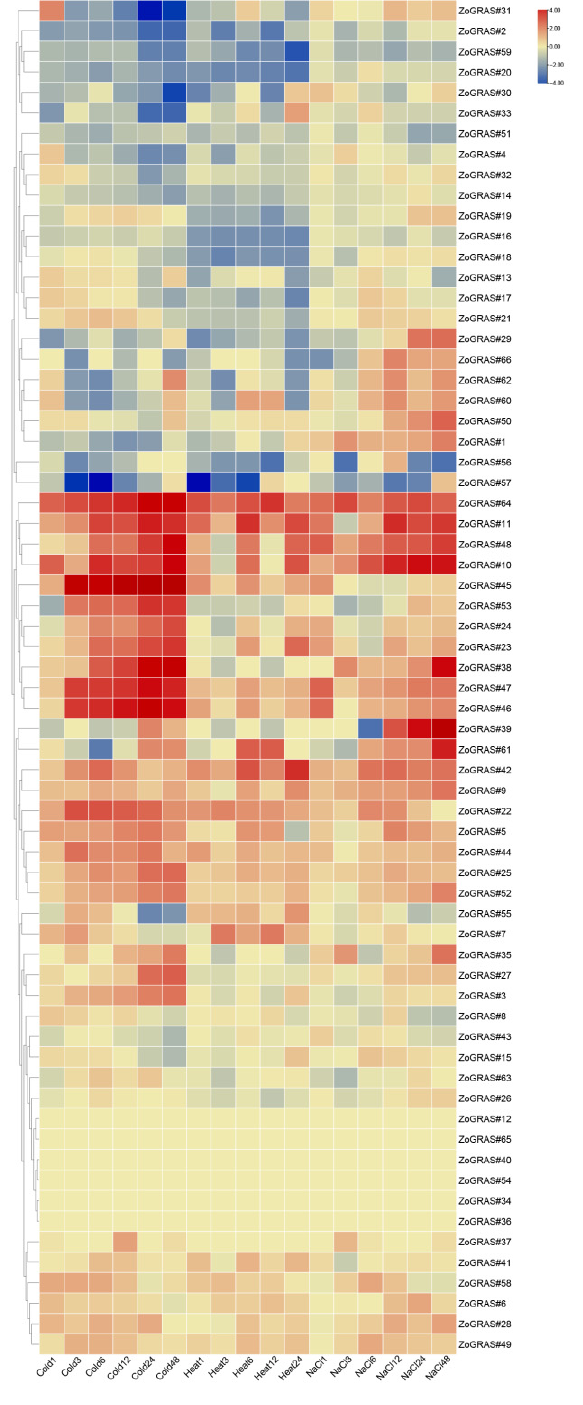
Figure 9. GRAS gene expression profile in ginger, including hierarchical clustering of GRAS gene expression profiles in ginger leaves under different stress conditions.